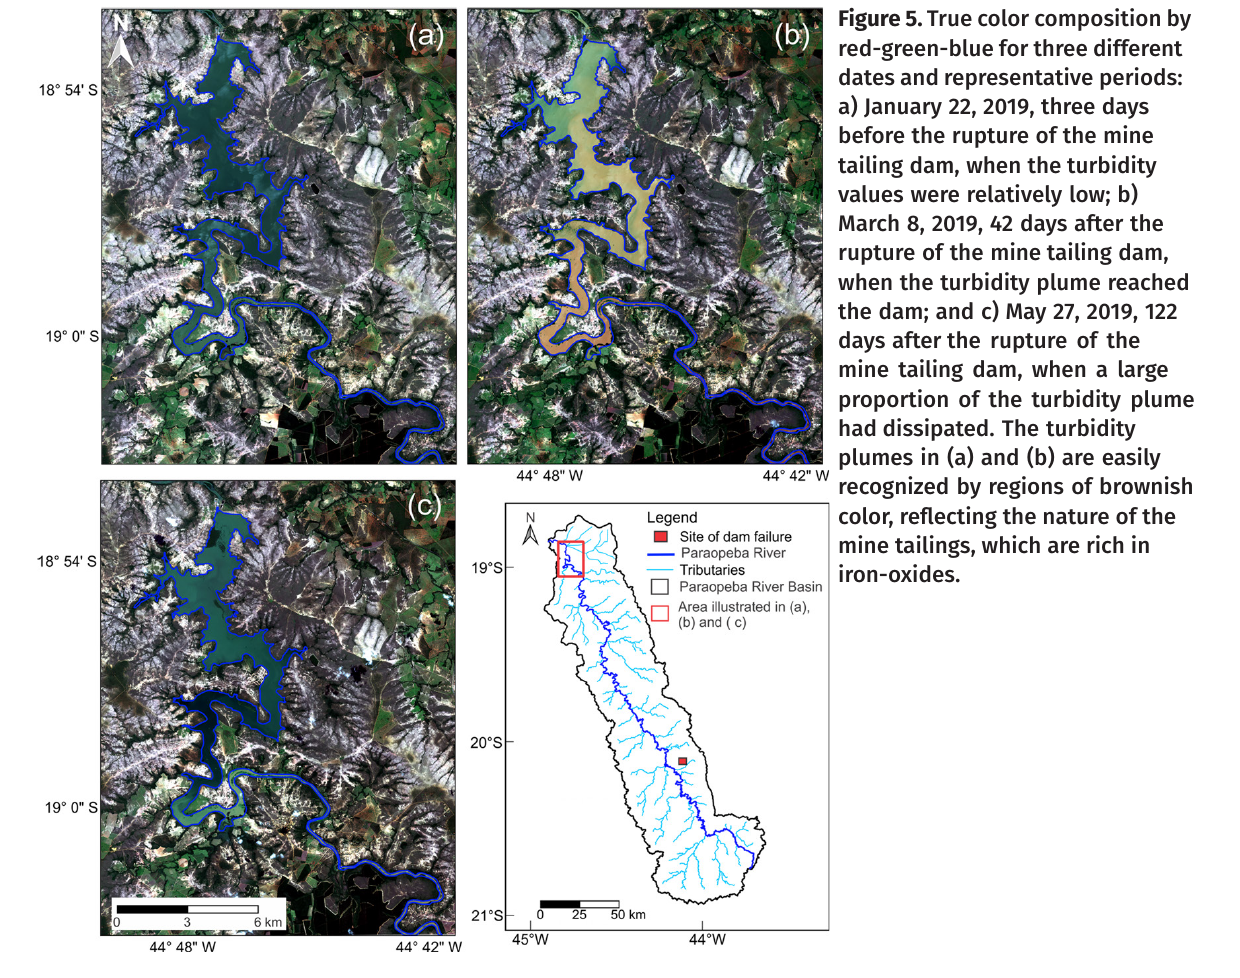
Figure 5. True color composition by red-green-blue for three different dates and representative periods: a) January 22, 2019, three days before the rupture of the mine tailing dam, when the turbidity values were relatively low; b) March 8, 2019, 42 days after the rupture of the mine tailing dam, when the turbidity plume reached the dam; and c) May 27, 2019, 122 days after the rupture of the mine tailing dam, when a large proportion of the turbidity plume had dissipated. The turbidity plumes in (a) and (b) are easily recognized by regions of brownish color, reflecting the nature of the mine tailings, which are rich in